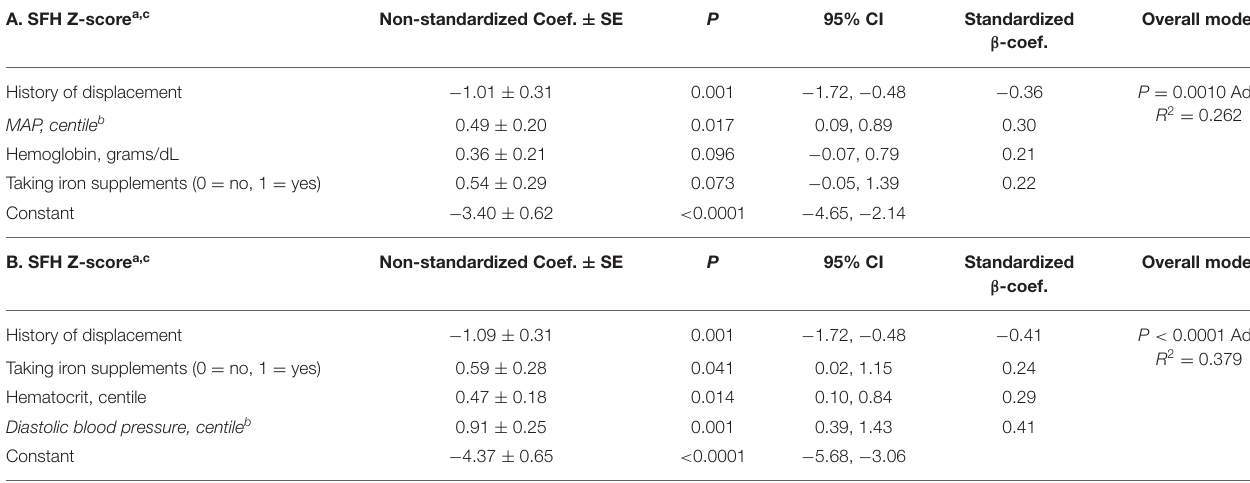
TABLE 5 | Multiple linear regression for Symphysis-fundal height (SFH) Z-scores, with (A) mean arterial pressure (MAP) and hemoglobin (grams/dL) and (B) diastolic blood pressure (DBP) and hematocrit (%).